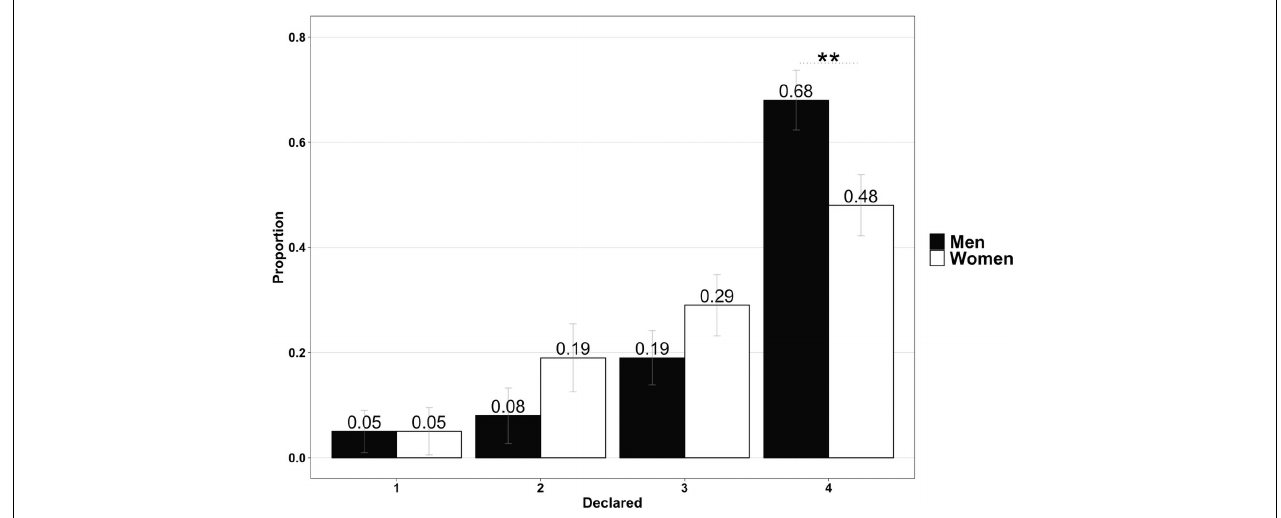
FIGURE 5 | Sub-maximizing cheating non-liars die outcomes obtained after several rolls (men vs. women). Error bars are represented in gray. Asterisks indicate significance in pairwise proportion comparisons: ** p < 0.01.